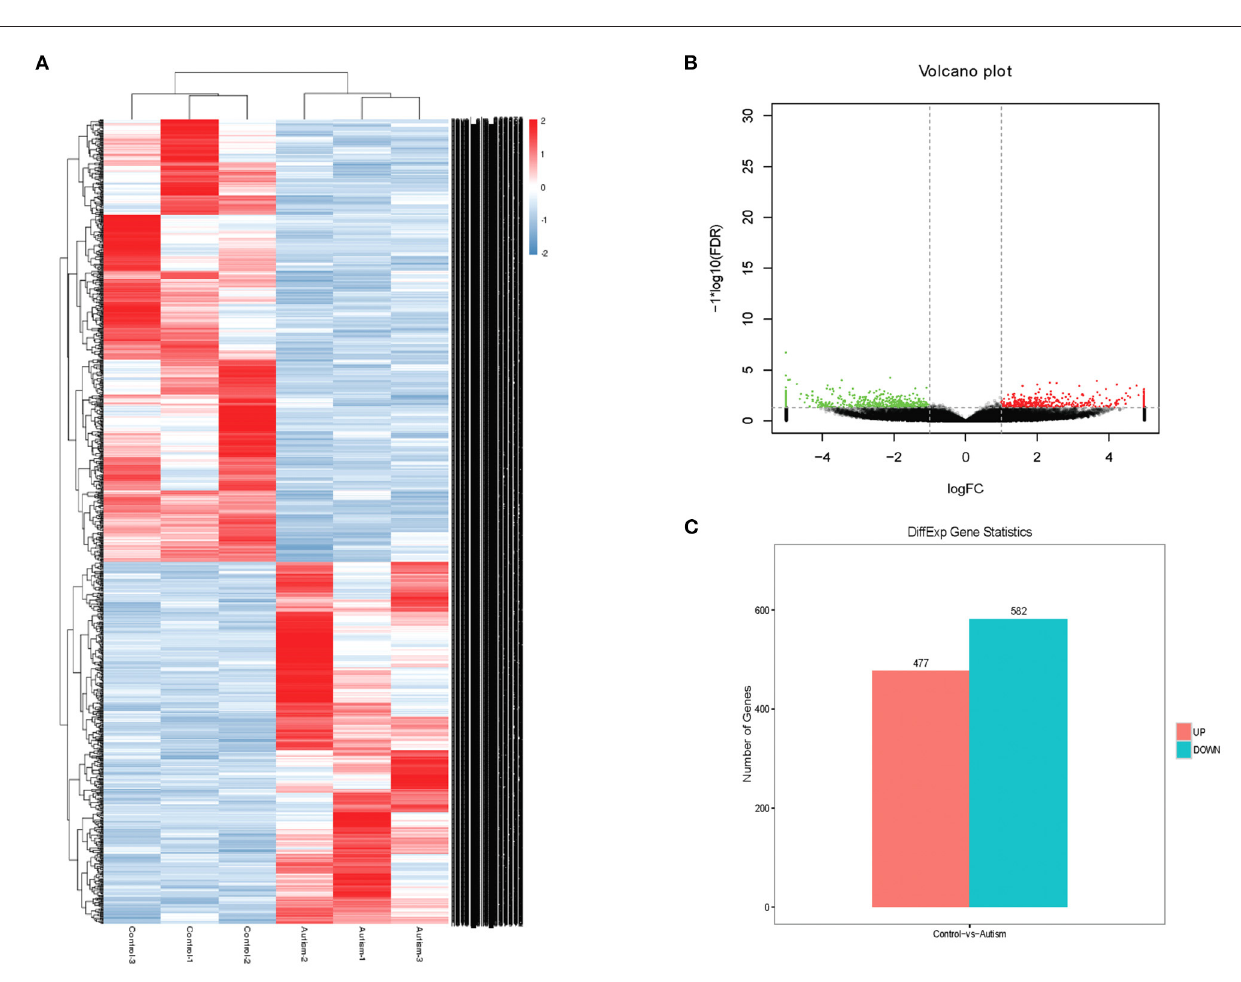
Frontiers in Genetics |